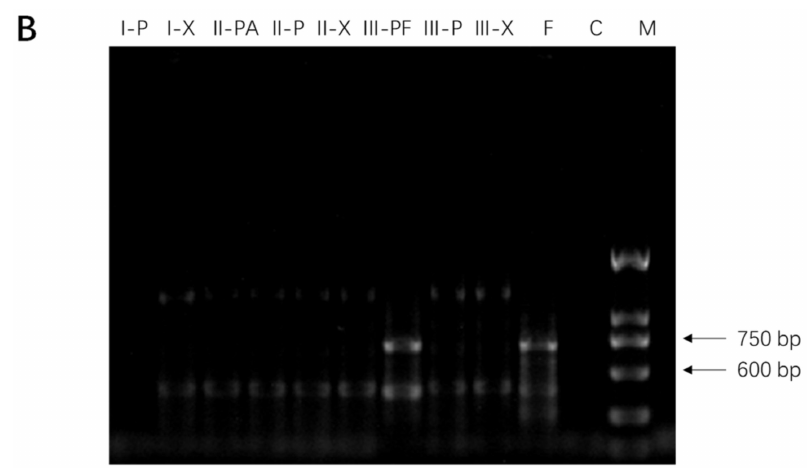
Figure 1. Detection of F. solani (strain F19, panel ( A )) and F. oxysporum (strain C1, panel ( B )) in American ginseng root tissues using polymerase chain reaction (PCR). Gel lanes show the presence of PCR products from left to right: (I-P), phloem of part I; (I-X), xylem of part I; (II-PA), phloem under PDA plugs of part II; (II-P), area adjacent to PDA plugs of part II; (II-X), xylem of part II; (III-PF), phloem under Fusarium culture plug of part III; (III-P), adjacent Fusarium culture plugs of part III; (III-X), xylem of part III; (F), positive control ( Fusarium spp.), (C), negative control (no DNA template), and (M), DNA